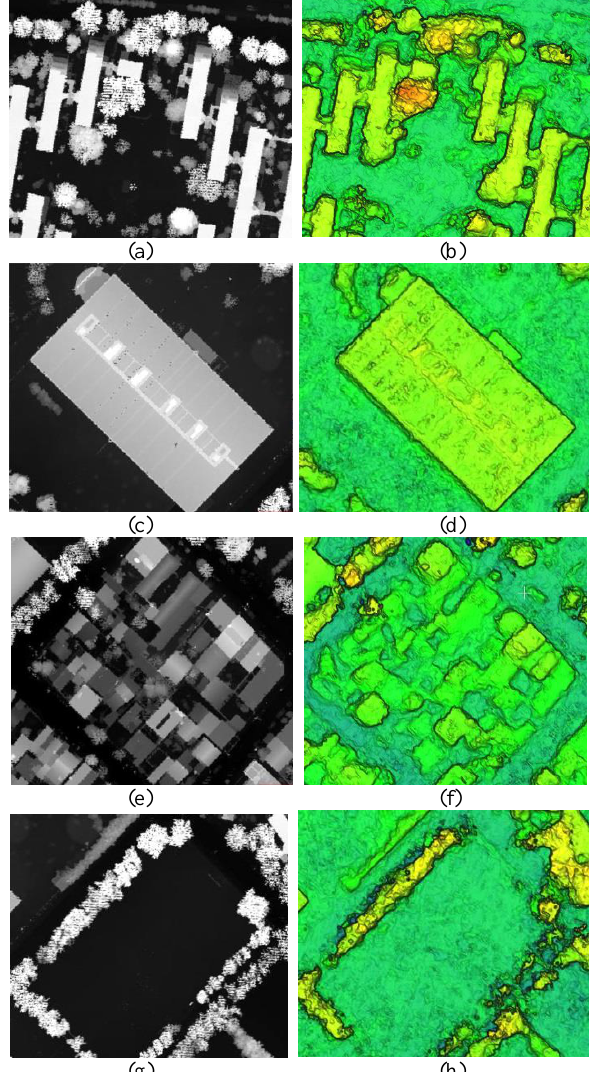
Figure 11. Detail comparison between the reference DSM and the generated 3D model Figure 11 (a), (c), (e), (g) are the sub-areas extracted from the reference LiDAR DSM, and Figure (b), (d), (f), (h) are the corresponding areas on the 3D model generated from the fused point cloud. Figure 11(a) and (b) display an area which contains buildings and trees. We can observe that most buildings and trees are well reconstructed and easy to distinguish. But the errors, if the trees are too close to the buildings. In Figure (c) and (d), we can find an isolated large building in the extracted area. The reconstructed building’s edge is sharp in Figure 11